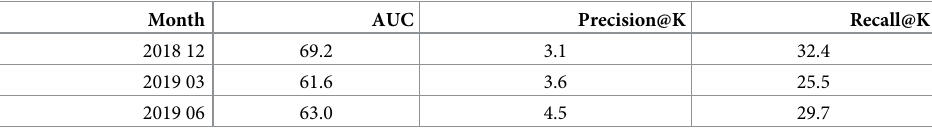
Table 4. Prediction performance of the 2-step model on the target